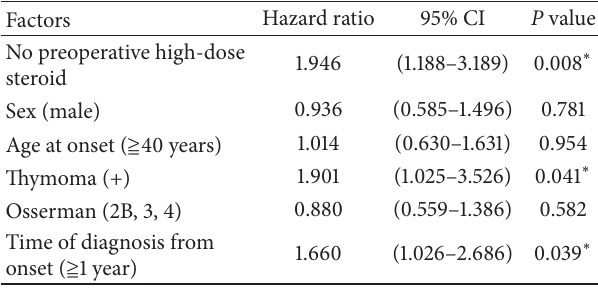
Table 2: Cox regression analysis of prognostic factors in MG pa- tients after thymectomy.